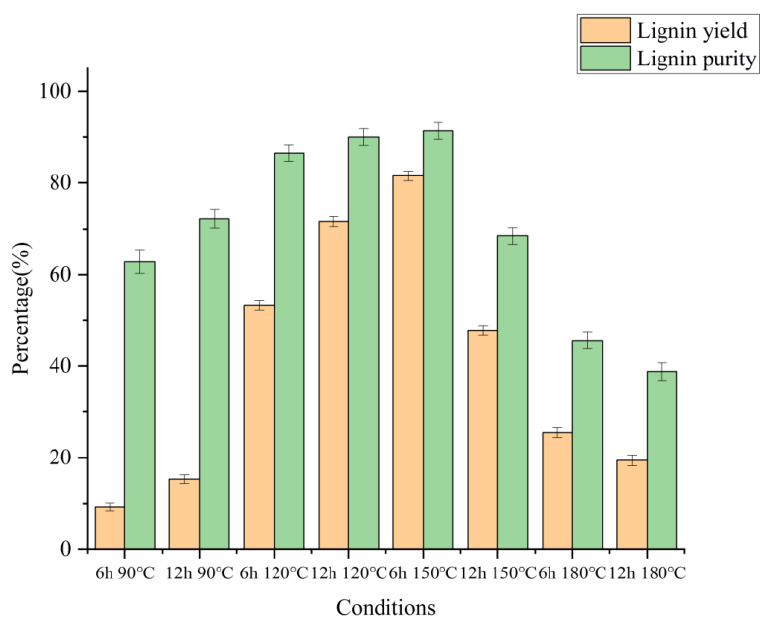
Figure 4. Extracted DES lignin yield of wheat straw obtained from various DES pretreatment conditions. The lignin purity was affected by the reaction time and temperature of the DES treatment. Increasing the treatment temperature from 90 ◦ C and 6 h to 150 ◦ C and 6 h results in significant improvements in both the lignin yield and lignin purity. However, increasing the treatment time further could not improve the lignin yield and purity. Lignin macromolecule contains a huge number of functional groups, such as aliphatic and phenolic hydroxyl groups. In the wheat straw cell wall, lignin is also linked to hemicellulose via various alkyl/aryl ether bonds to form the lignin-carbohydrate complexes [30]. The increase in temperature made the protons more active, causing full β -O-4 bond cleavage in lignin. Meanwhile, with the increase in temperature, DES cleaved the bonds between hemicellulose and lignin and the ether bonds in lignin, which might be an important factor in promoting lignin extraction [21]. As the pretreatment became more stringent, the cellulose structure in the system began to collapse and gradually converted into other chemicals (such as sugar chaff). On the other hand, the lignin molecules were treated so seriously that they were harder to extract, and some lignin molecules were adhered to the surface of wheat straw, so the lignin yield and lignin purity